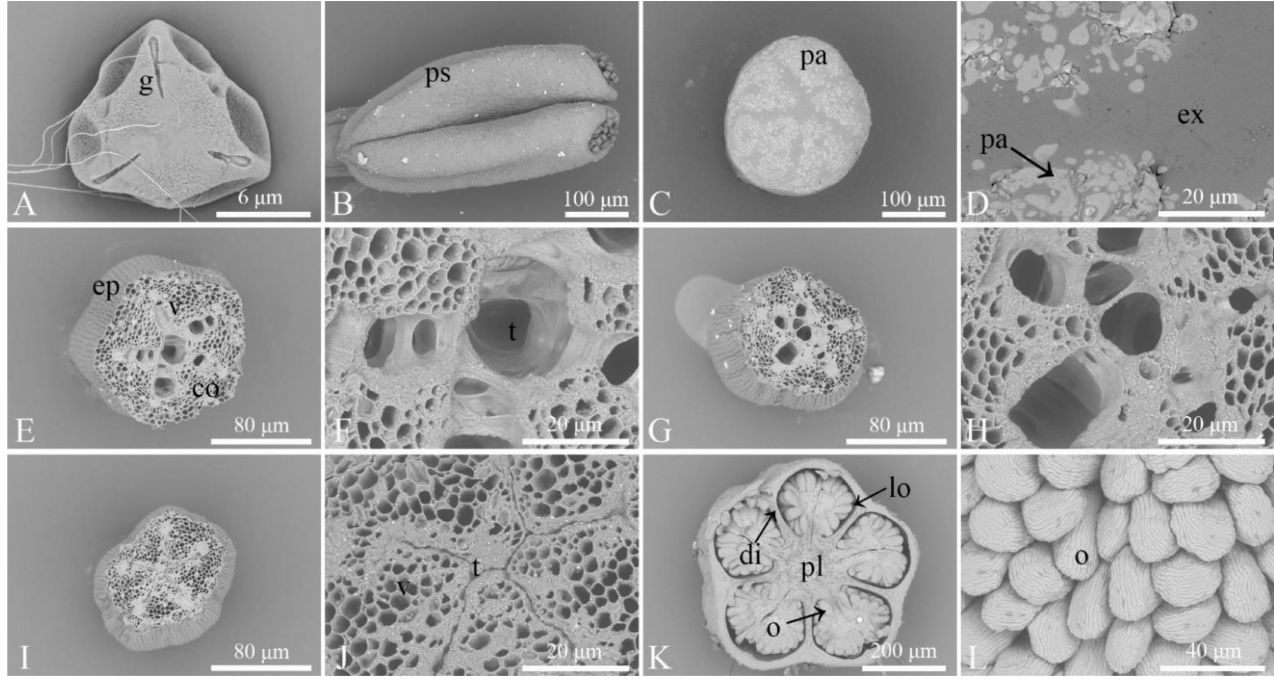
Figure 1. SEM of various parts of floral organs. ( A ): pollen tetrad; ( B ): anther; ( C ): overhead shot of the stigma; ( D ): central area of the stigma; ( E ): upper part of the style; ( F ): upper central area of the style; ( G ): middle part of the style; ( H ): central area of the middle part of the style; ( I ): lower part of the style; ( J ): central area of the lower part of the style; ( K ): ovary; ( L ): ovule. g: germinal aperture; ps: pollen sac; pa: papilla; ex: exudate; ep: epidermis; v: vascular bundle; co: cortex tissue; t: transmitting tissue; di: diaphragm; o: ovule; pl: placenta; lo: